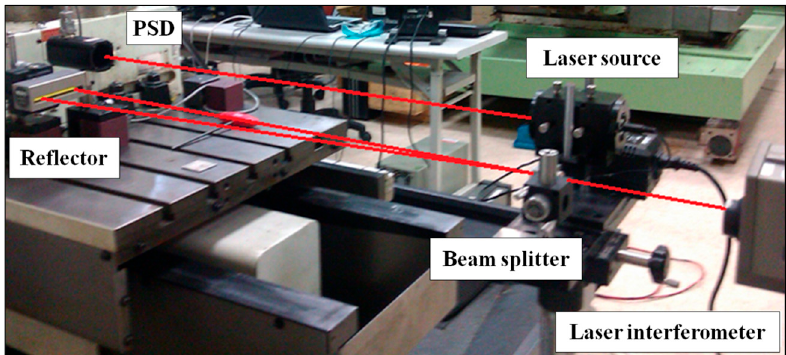
Figure 2. Setup of PSD calibration using a laser interferometer.